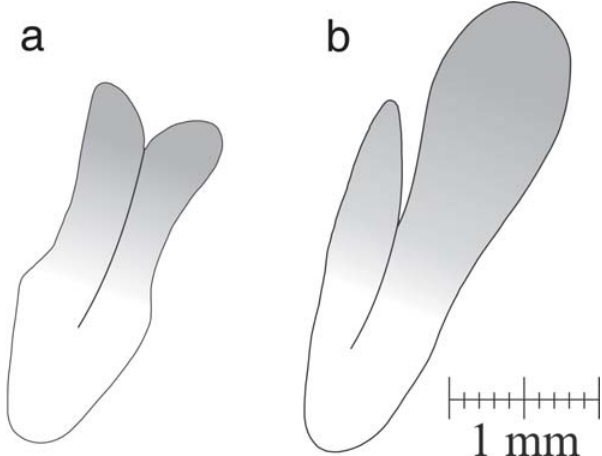
Fig. 2. Bicuspid premaxillary teeth of a, Hypostomus denticulatus with symmetrical cusps, and b, H. ternetzi with asymmetrical cusps. Ventral view.